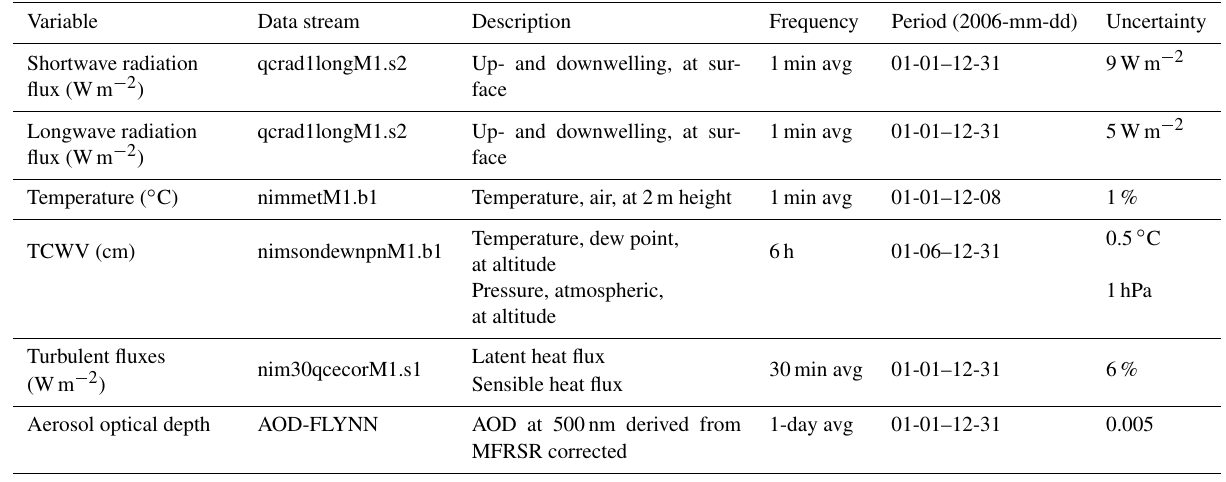
Table 1. Radiative and non-radiative data used from the AMF, with dates for which the data stream is available in 2006. Data are available from the ARM archive: